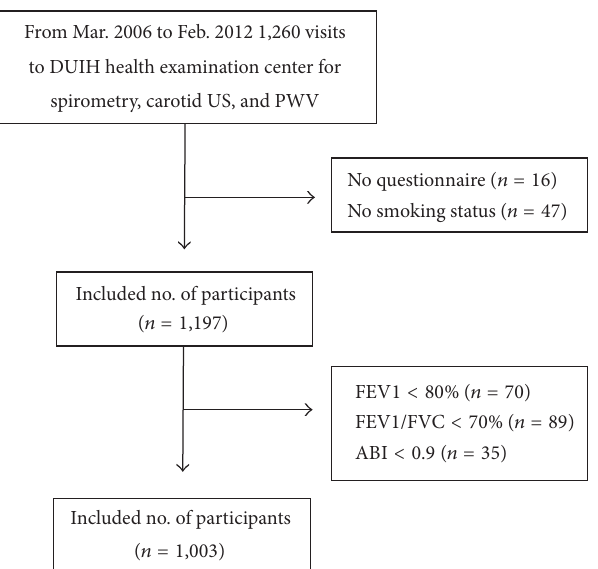
Figure 1: Baseline characteristics of the